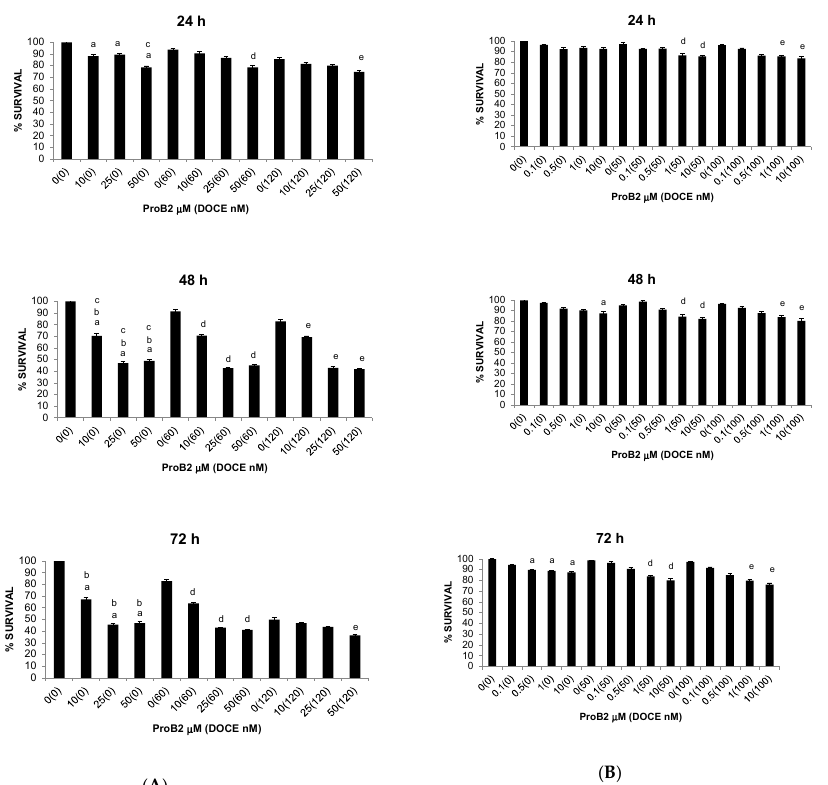
Figure 3. Trypan blue dye exclusion assay results showing viability of MCF-7 ( A ) and T47D ( B ) BC cells under different concentrations of the test compound (ProB2, DOCE, ProB2 + DOCE) at 24 h, 48 h and 72 h. Columns, mean; bars, SE (n = 3). a represents the significant difference between ProB2 treatment alone and control treatment; b represents the significant difference between ProB2 treatment alone for 48 or 72 h and ProB2 treatment alone for 24 h; c represents the significant difference between ProB2 treatment alone and 120 nM DOCE alone; d represents the significant difference between combination treatment (ProB2 + DOCE 60 nM or DOCE 50 nM) and 60 nM DOCE or 50 nM DOCE alone; e represents the significant difference between combination treatment (ProB2 + DOCE 120 Nm or DOCE 50 nM) and 120 nM DOCE or DOCE 50 nM alone ( p < 0.05; one-way ANOVA). Abbreviations: DOCE, docetaxel; ProB2, procyanidin B2.